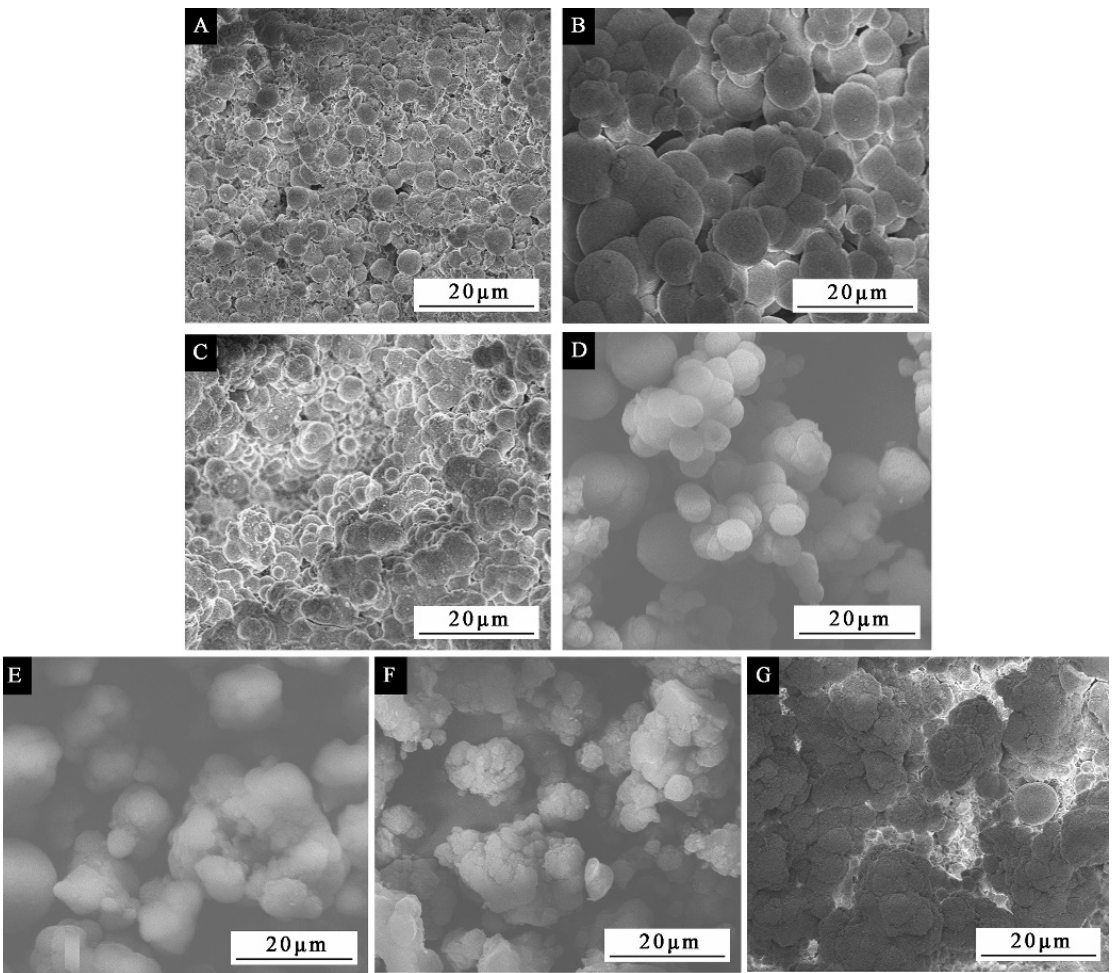
Figure 6. The SEM appearance of microcapsules by single factor experiment: mass ratio of core to shell ( A ) 0.42:1, ( B ) 0.50:1, ( C ) 0.58:1, ( D ) 0.67:1, ( E ) 0.75:1, ( F ) 0.83:1, ( G ) 0.92:1.